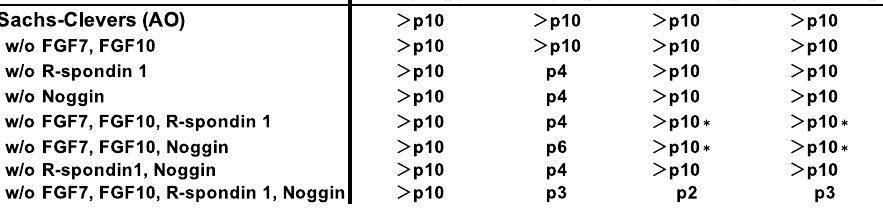
Fig. 4 Effects on lung tumoroids (PDTs) and normal lung organoids (PDOs) by AO media modi fi cation. a Shown are bright- fi eld microscopy images of PDTs and PDOs. Growth factors that comprise AO media were removed from AO media as indicated to determine which growth factors are indispensable for the growth of lung tumoroids and normal lung organoids. Representative images of the PDTs/ PDOs in each condition at the passage number indicated in c are shown. Scale bar, 200 μ m. b The growth of the tumoroids/organoids was quanti fi ed by measuring three independent areas of the tumoroid/organoid occupancy ratio in the images shown in a . Data are shown as mean ± SD. c Passage numbers of the PDTs and PDOs in the indicated media conditions are assessed to determine which condition are most suitable for culture. We noted that a number of the conditions slowed the growth of normal lung organoids though they were passaged over 10 times (depicted as